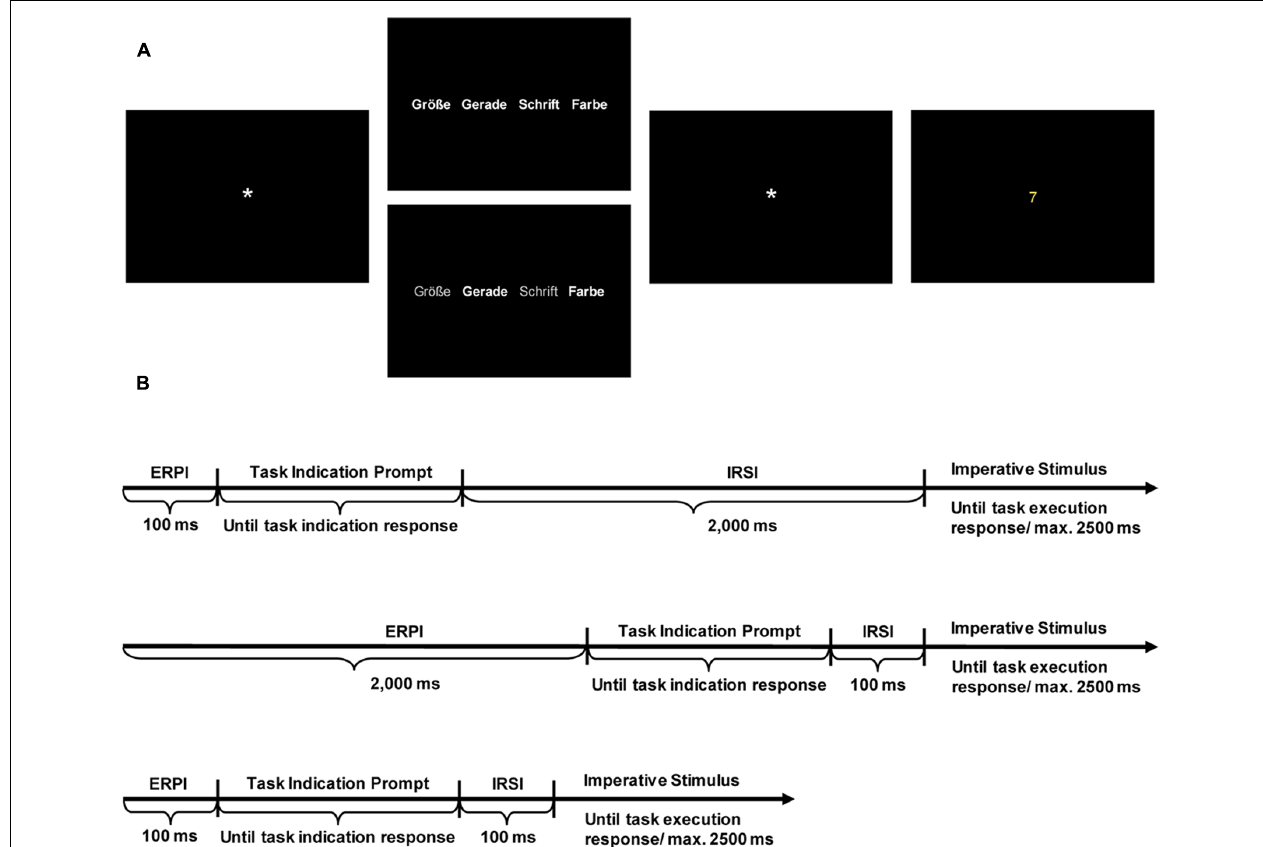
FIGURE 1 | (A) Schematic illustration of the displays used in a single trial (in chronological order). Asterisk indicates fixation mark. (B) Schematic illustration of the procedure of single